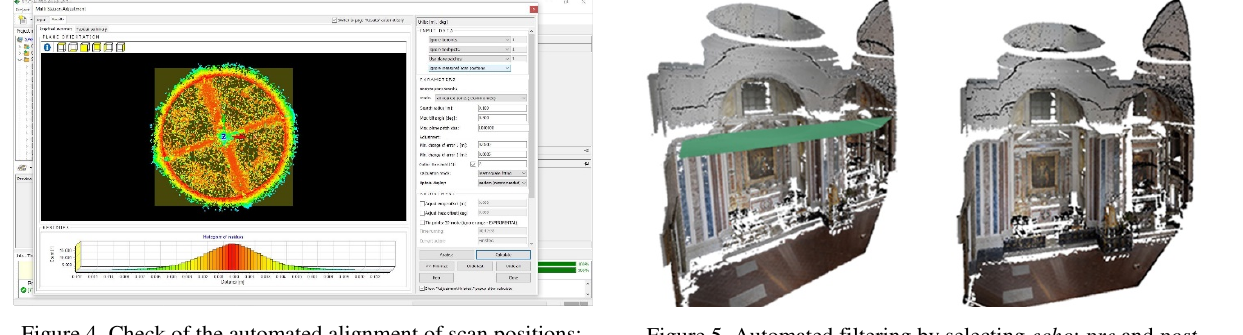
Figure 5. Automated filtering by selecting echo : pre and post - cleaning point